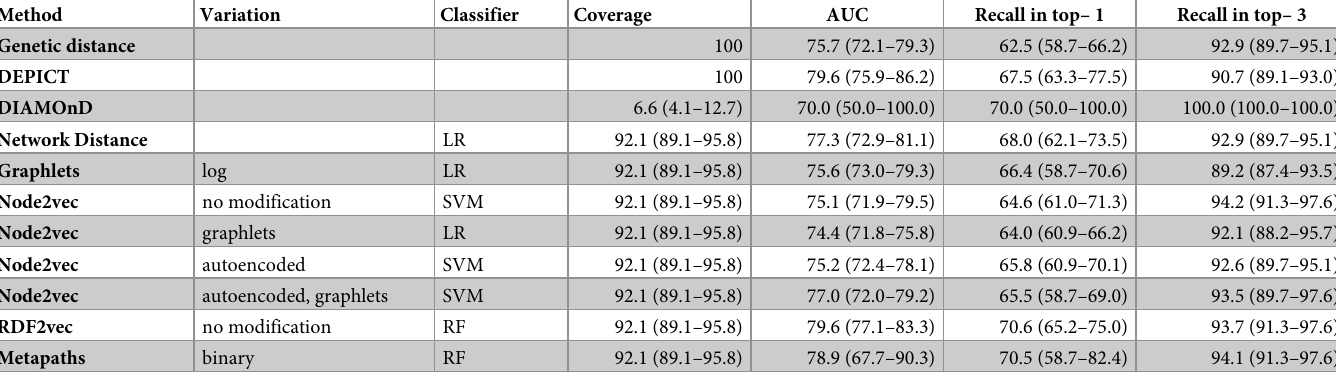
Table 3. Performances achieved with different combinations of methods, variations, and classifiers. All values are percentages and indicate the average (minimum value–maximum value) across the four reference